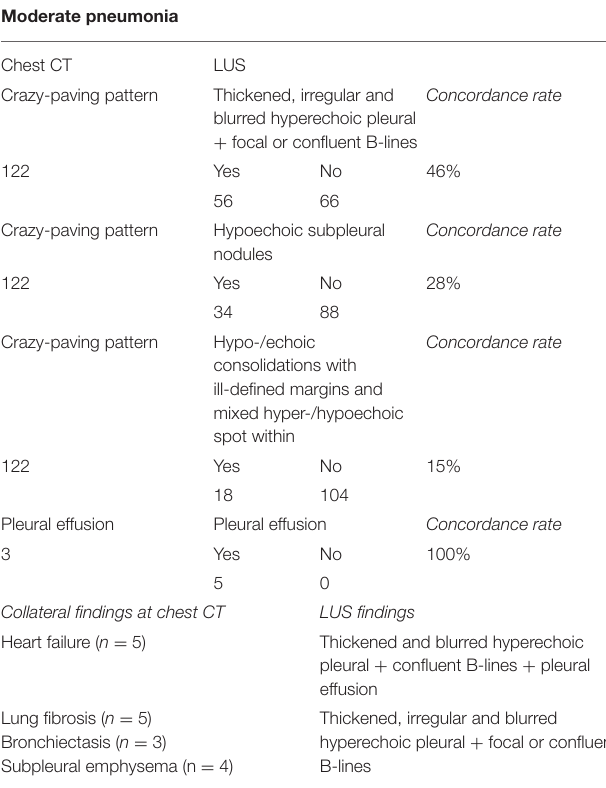
TABLE 4 | Concordance rate between LUS and CT in patients with initial moderate CT scan findings. Moderate